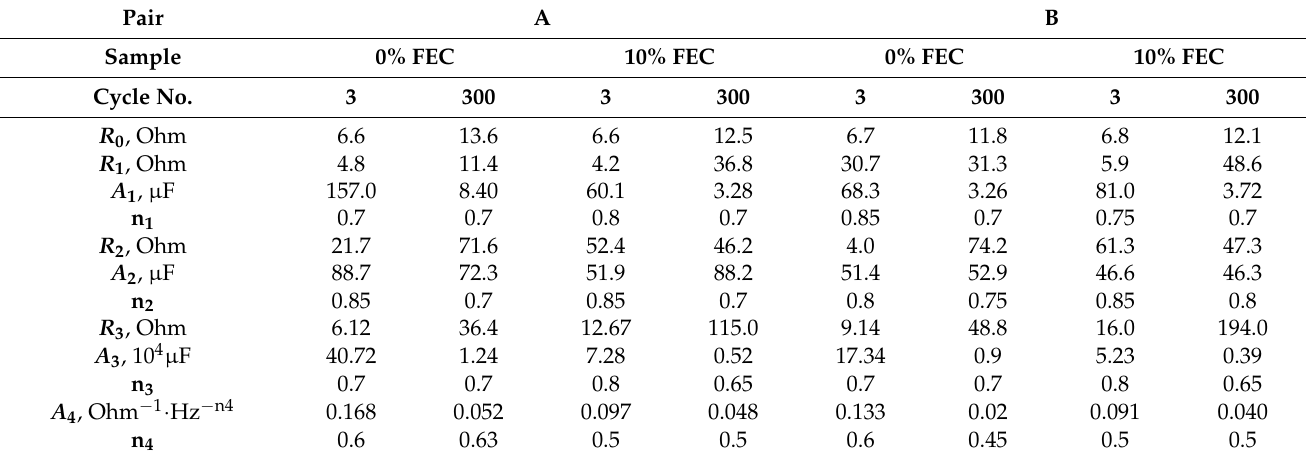
Table 2. Calculated values of the parameters of the equivalent circuit for the impedance spectra in the lithiated state of Si/C electrodes for the 3rd and 300th